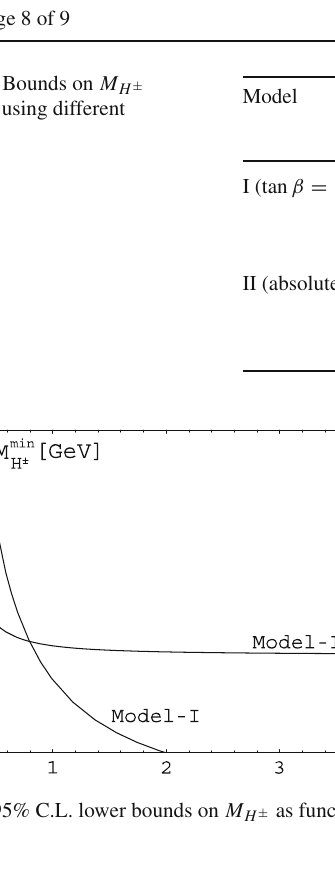
are shown for Model II. In the Model I case, the lower rather than the upper 1-sided intervals are